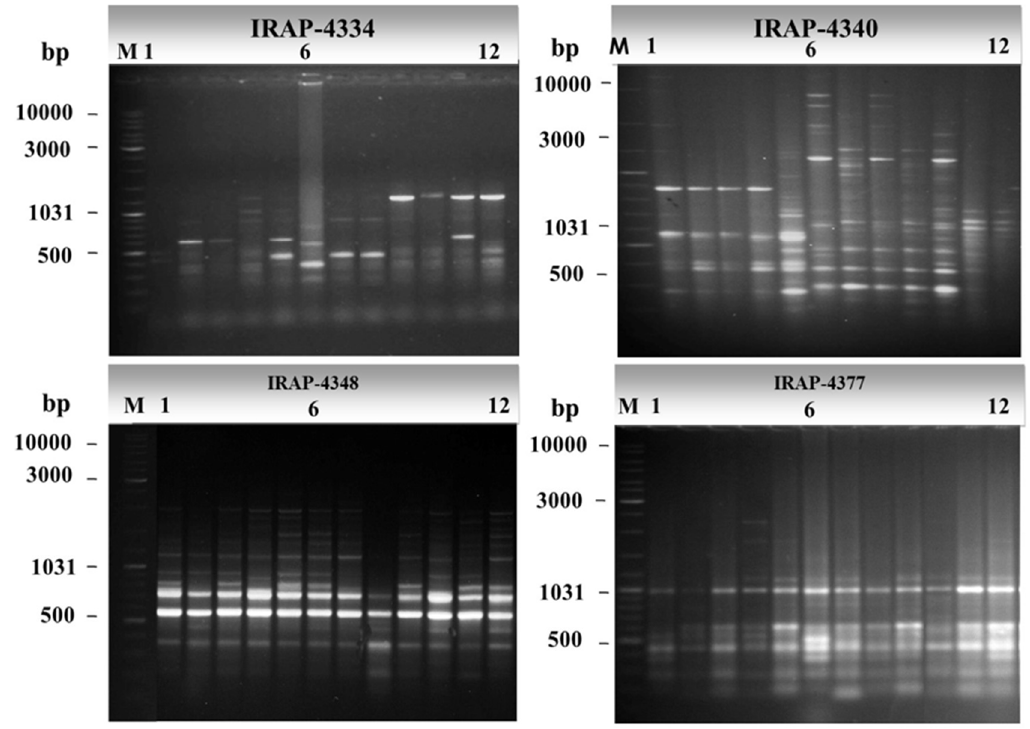
Figure 1. Agarose gel electrophoresis of PCR amplicons of some representative IRAP primers showing polymorphism of IRAP markers. DNA size marker Gene-Ruler 1 Kb plus DNA ladder (lane M) was used as molecular size standards in bps. Numbers from 1 to 12 refer to the sampling numbers of studied cultivars.